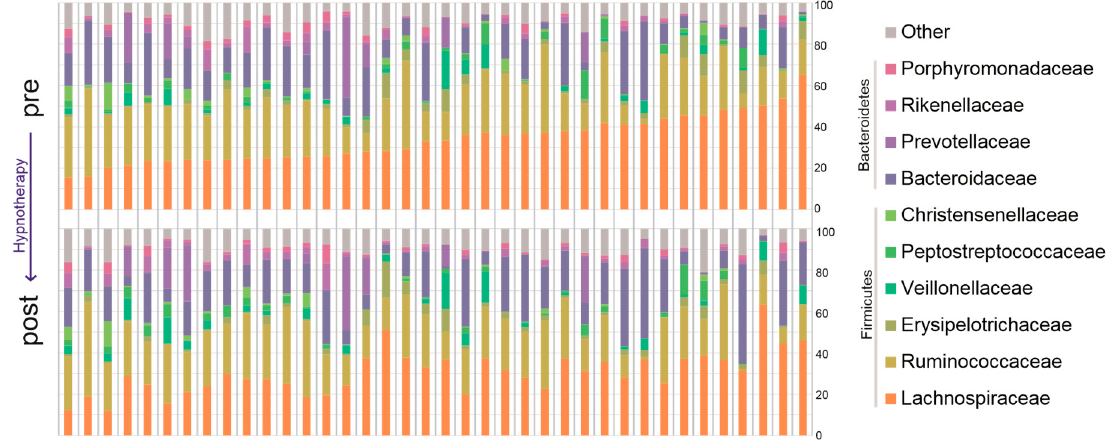
Figure 1. Relative abundance of the ten most prevalent bacterial families before and after gut-directed hypnotherapy (GHT).